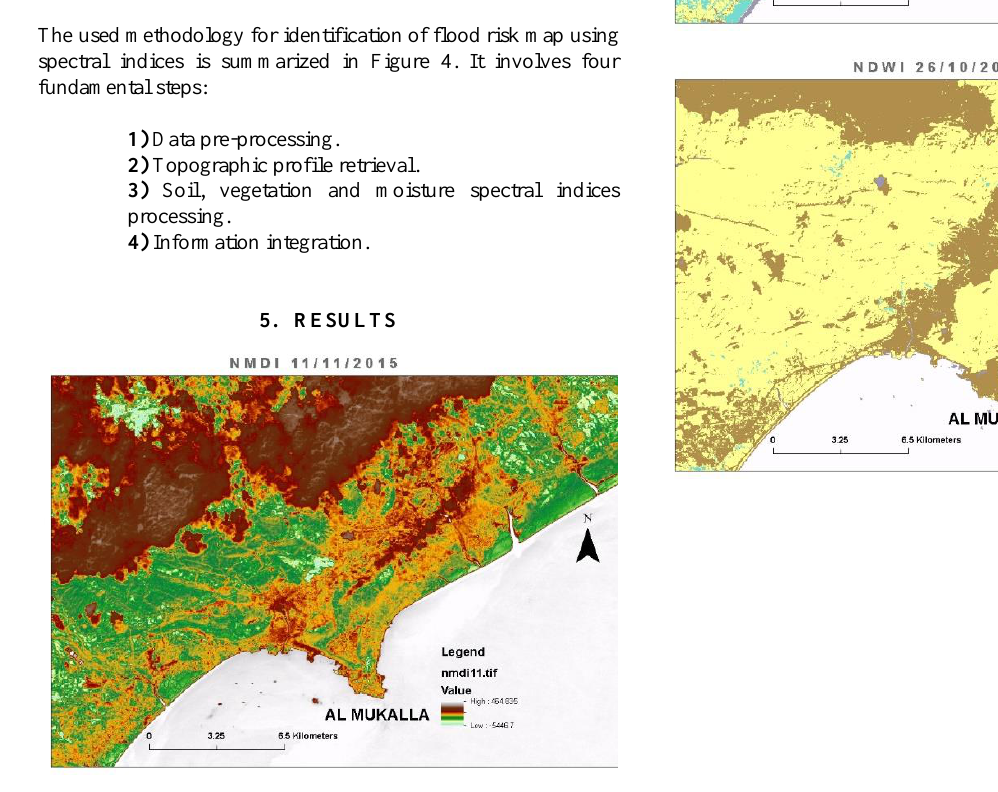
Figure 5. Methodology